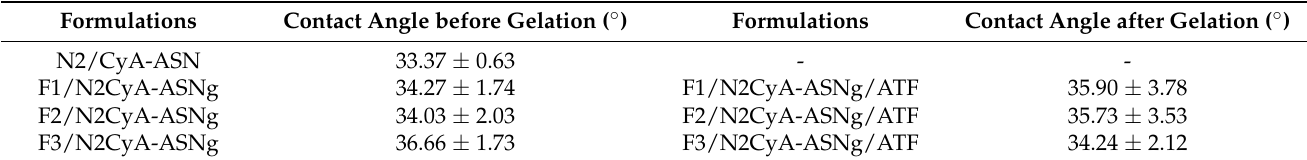
Table 7. Contact angle measurements (mean ± SD, n = 6).